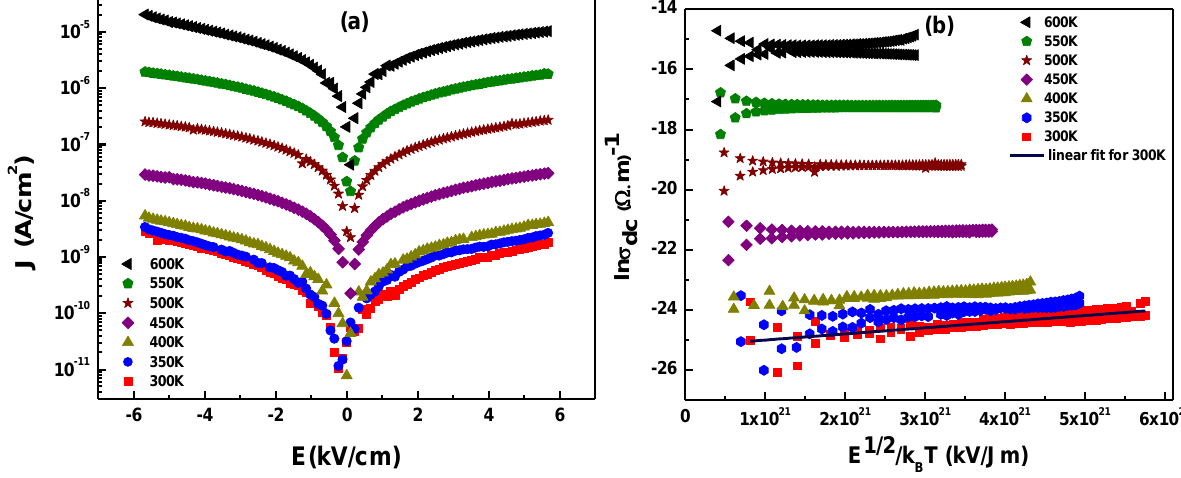
Figure 8. ( a ) Temperature dependency of leakage current density of the Pt/LaGdO (bulk)/Pt MIM capacitor; ( b ) the Poole–Frenkel plot of the temperature dependence of the DC conductivity at various applied electric fields. Reprinted with permission from